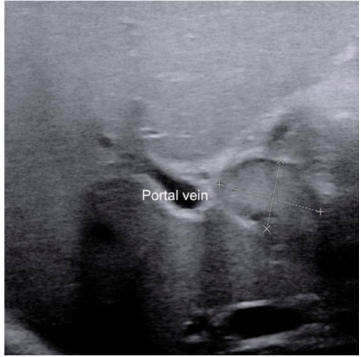
Figure 4. The presence of enlarged hepatic hilar lymph node (calipers) in infants with biliary